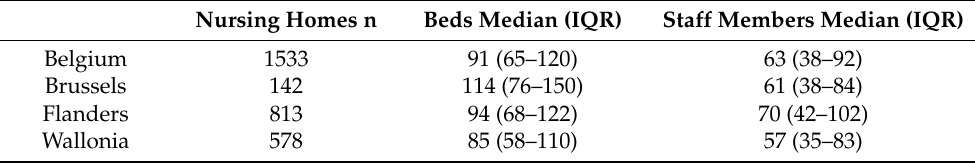
Table 2. Nursing homes participating in the COVID-19 surveillances, overall and by regional health